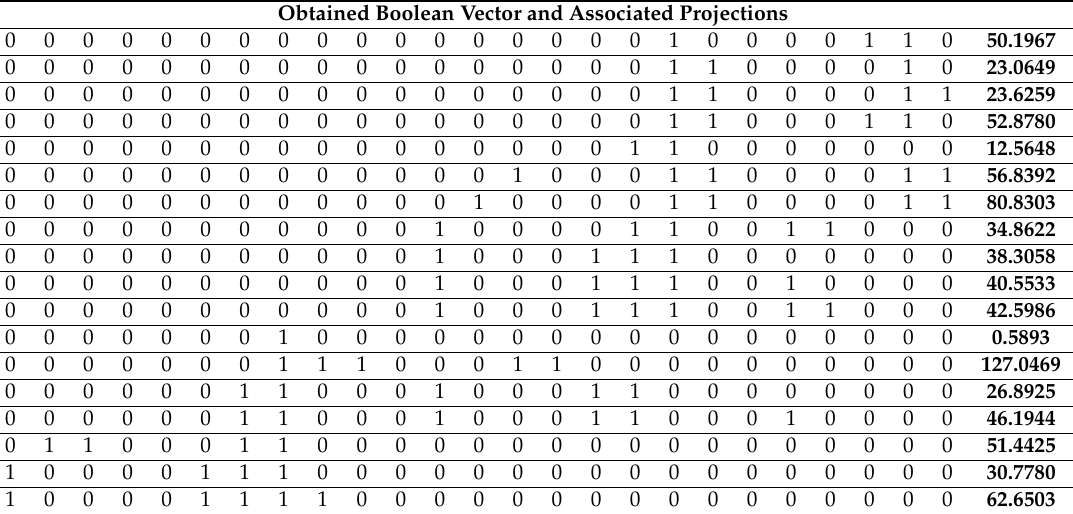
Table 11. Table of received data. The first column contains the values of the boolean vectors, and the second the projection